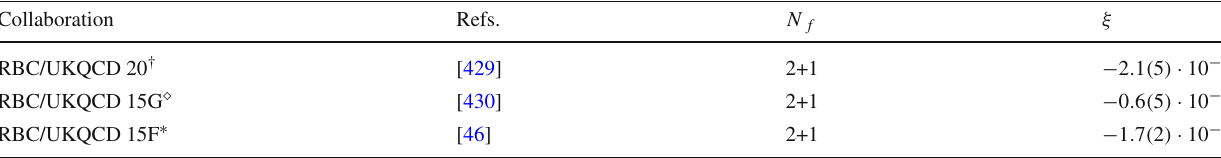
Table 30 Results for the parameter ξ = Im ( A 0 )/ Re ( A 0 ) obtained through the combination of lattice-QCD determinations of K → ππ decay amplitudes with N f = 2 + 1 dynamical flavours and experimental inputs Collaboration Refs. N